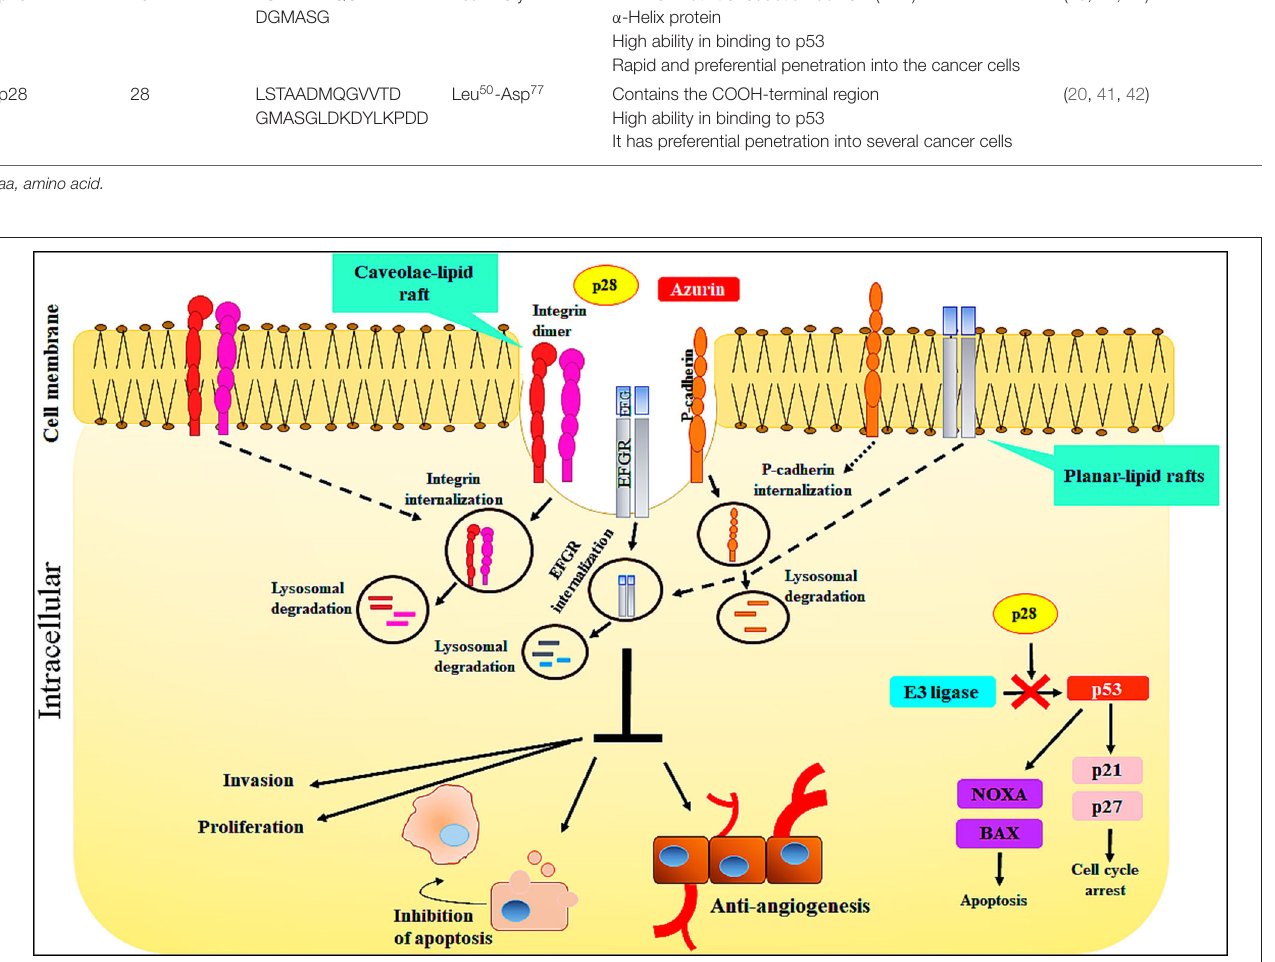
FIGURE 2 | The action mechanisms of Azurin and Azurin-p28 against cancer cells. Azurin and Azurin-p28 enter the cancer cells through planar- or caveolae-lipid raft and cell-surface receptors. Upon entry, p28 destroys the cancer cells by multiple